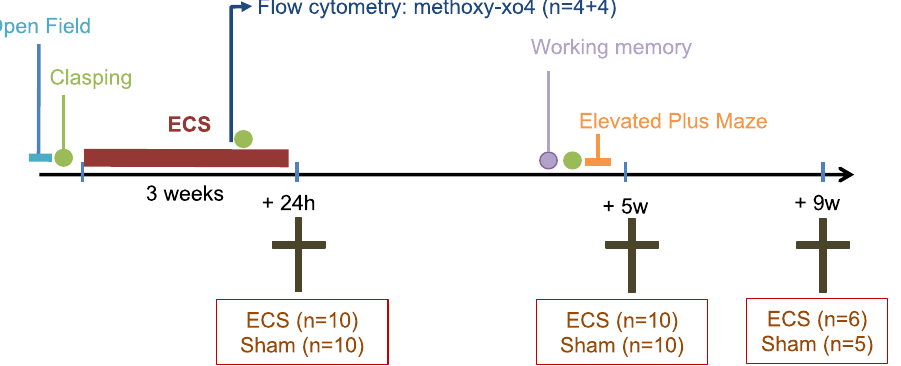
Figure 5. Experimental outline. Timeline of the study presenting the individual steps before and after ECS until animals were